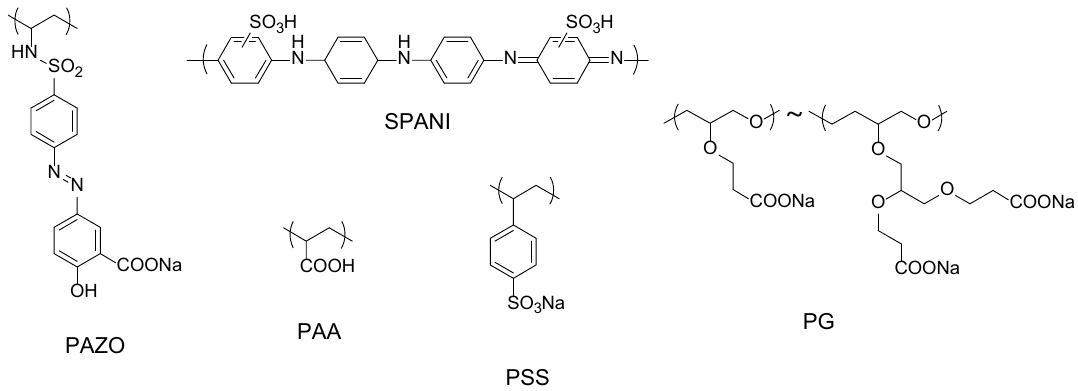
Figure 3. Chemical structures of polyanions used for the construction of dendrimer LbL films.